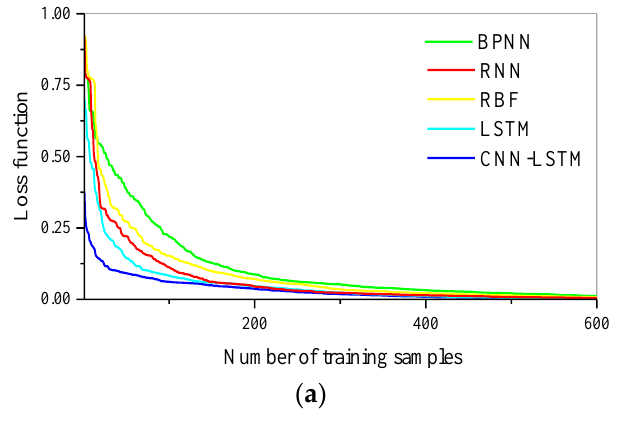
Figure 10. Error Change in Loss Function.